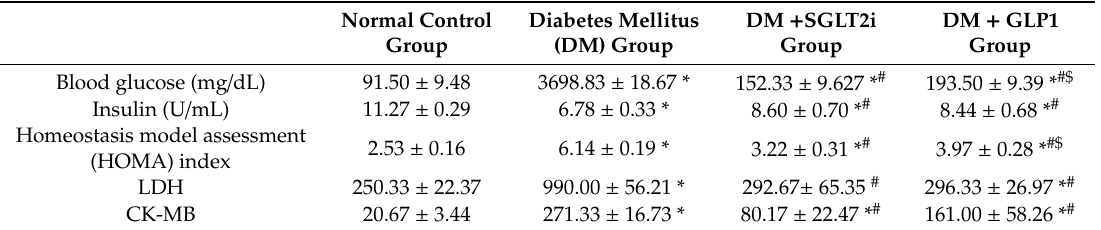
Table 1. E ff ects of SGLT2i and GLP1 analogues on glucose homeostasis and cardiac enzymes in diabetic